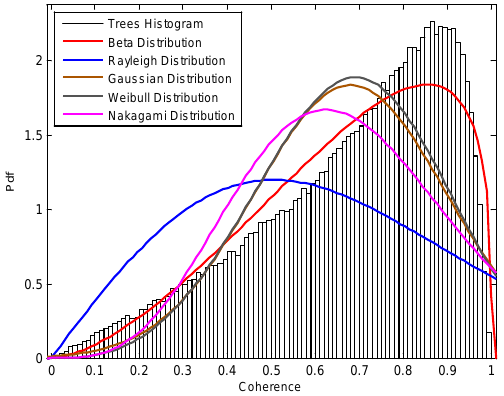
Figure 4. The performances of different statistical models for trees. Fig.4 demonstrates the performances of different statistical models for trees. The black bins represent the empirical pdf for trees. As shown in this figure, the Beta distribution also reveals the best performance among the five selected models. The performance of Gaussian model is not as good as the Beta